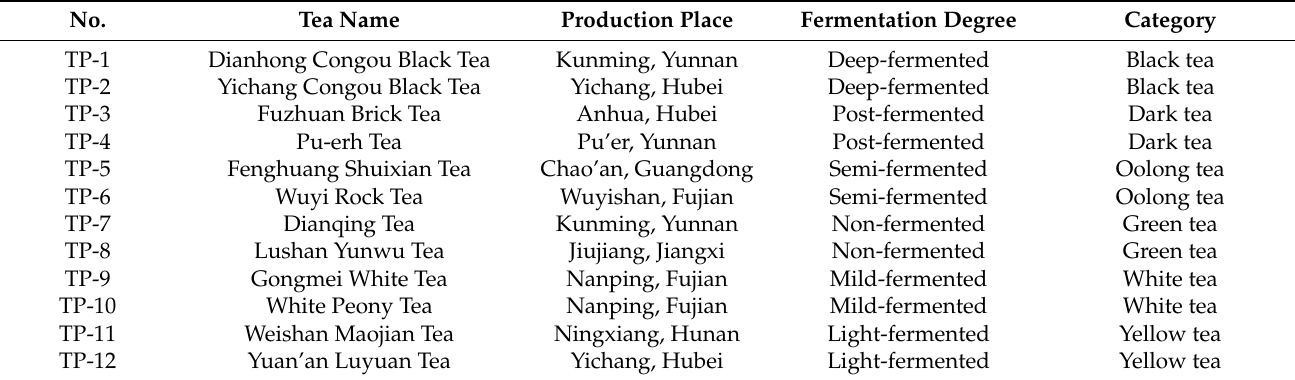
Table 1. Basic information about the 12 selected Chinese